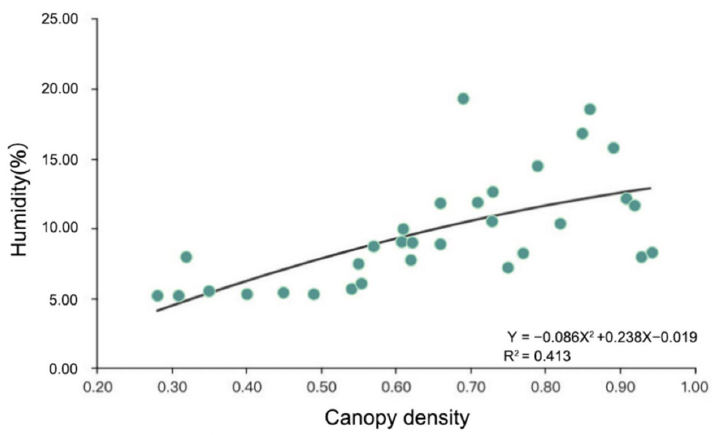
Figure 4. Relationship between humidification and canopy density.